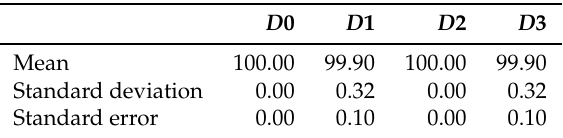
Table 12. Repeatability of the SHM strategy (10 times): scenario 2 and sum of the inverse distances approach. D 0: healthy state of the structure; D 1, D 2, and D 3: added masses at the positions indicated in Figure